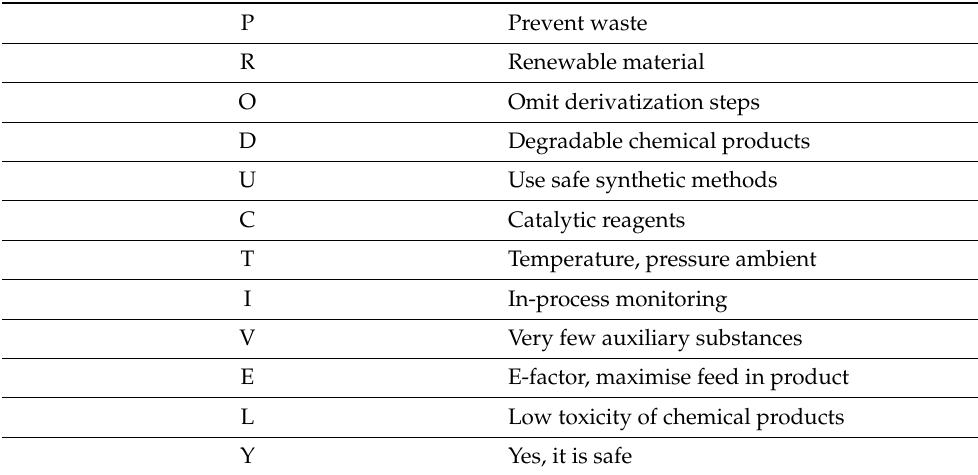
Table 1. The 12 principles of green chemistry summarized by the acronym